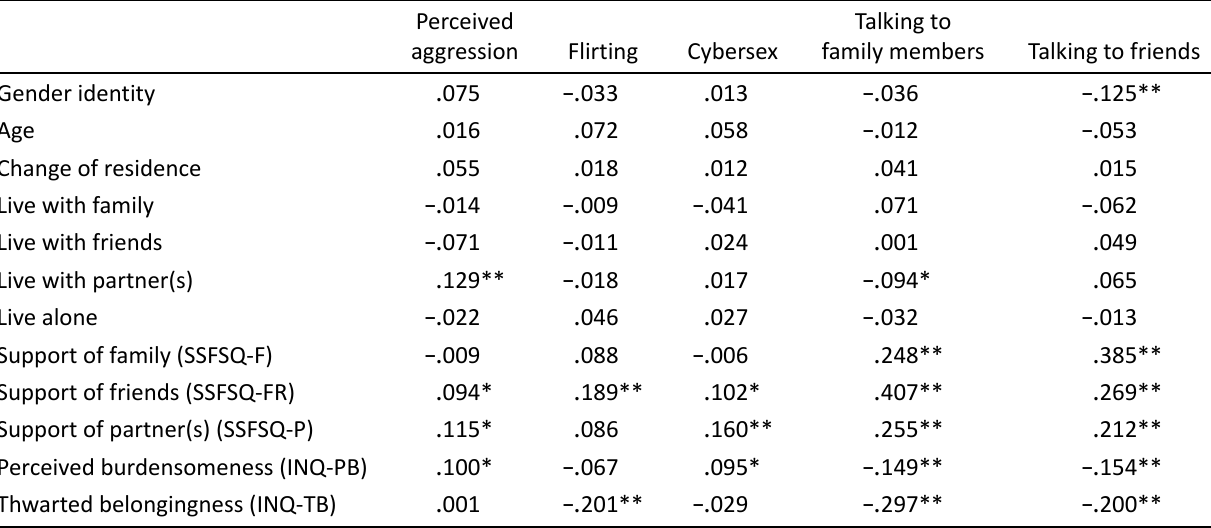
Table 2. Correlations of the whole sample with current network